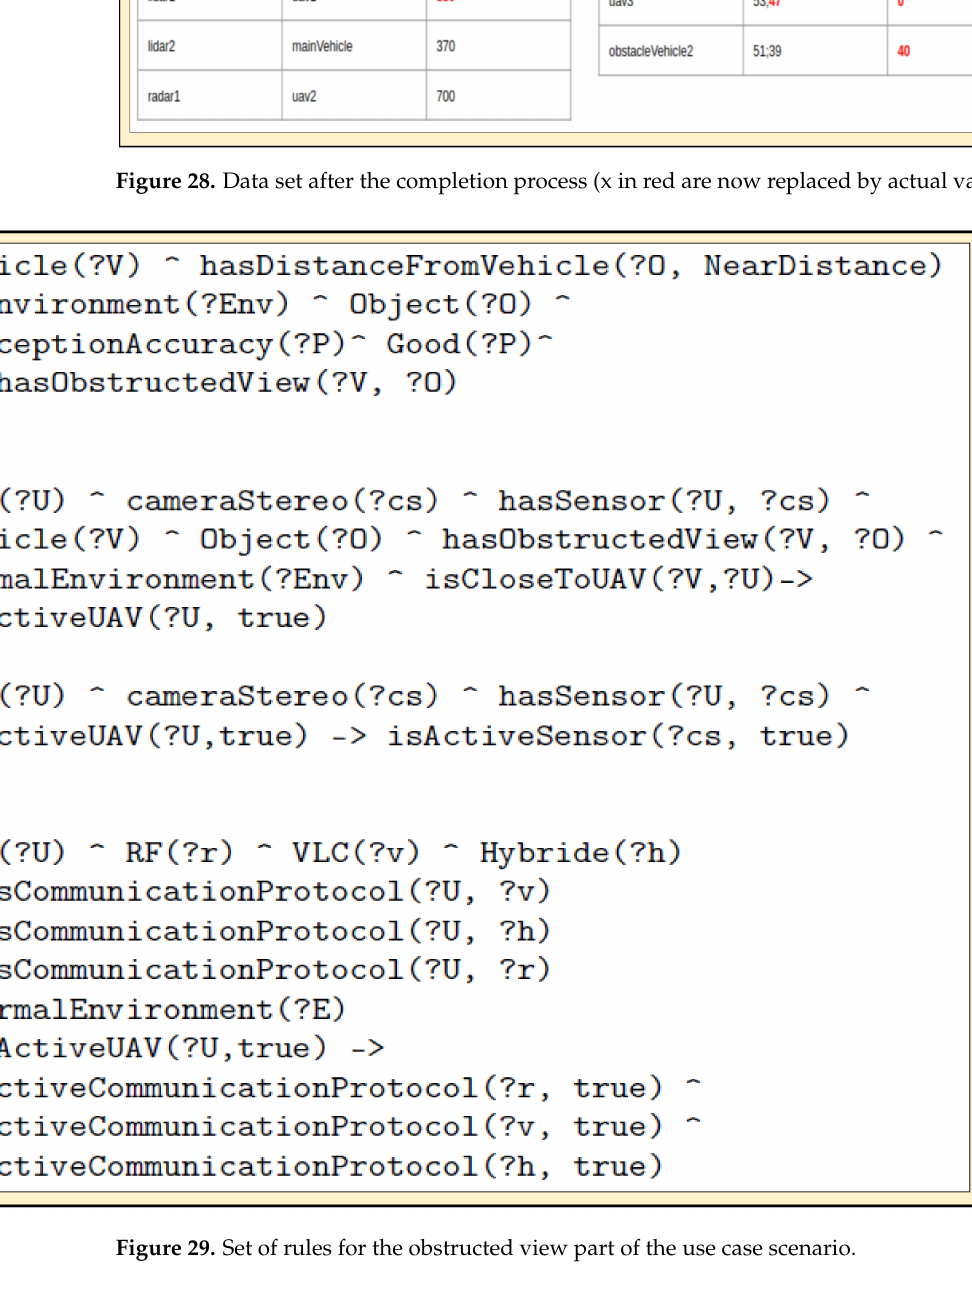
Figure 29. Set of rules for the obstructed view part of the use case